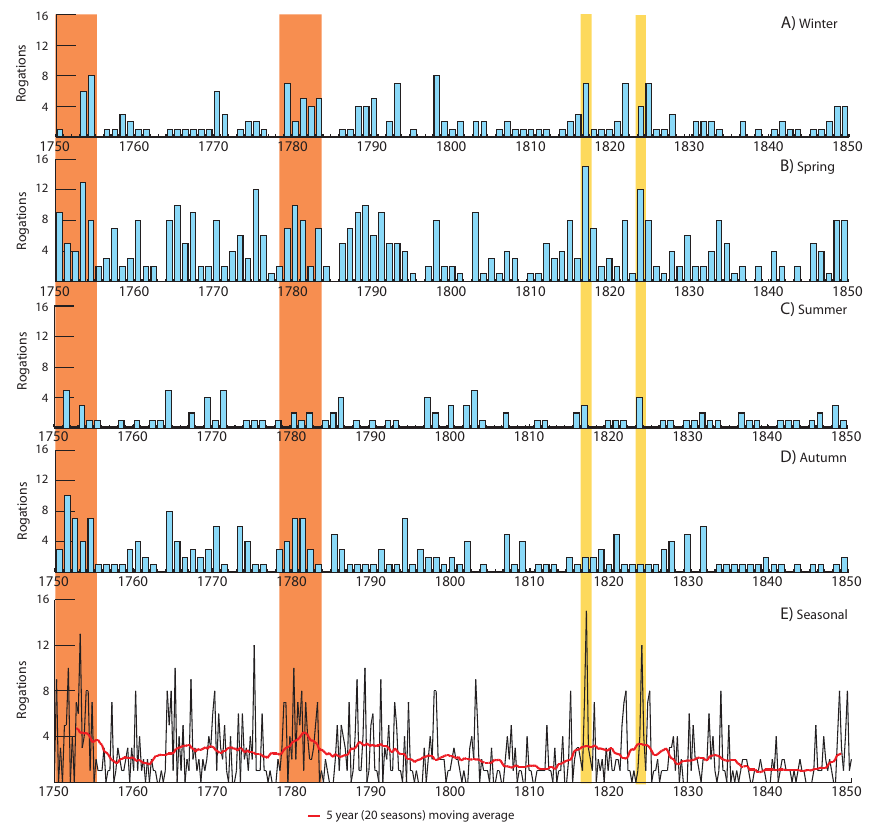
Fig. 3. Number of sites with rogations in winter (A) , spring (B) , summer (C) , autumn (D) and complete seasonal time series (E) . Highlighted specially dry periods (orange) and years